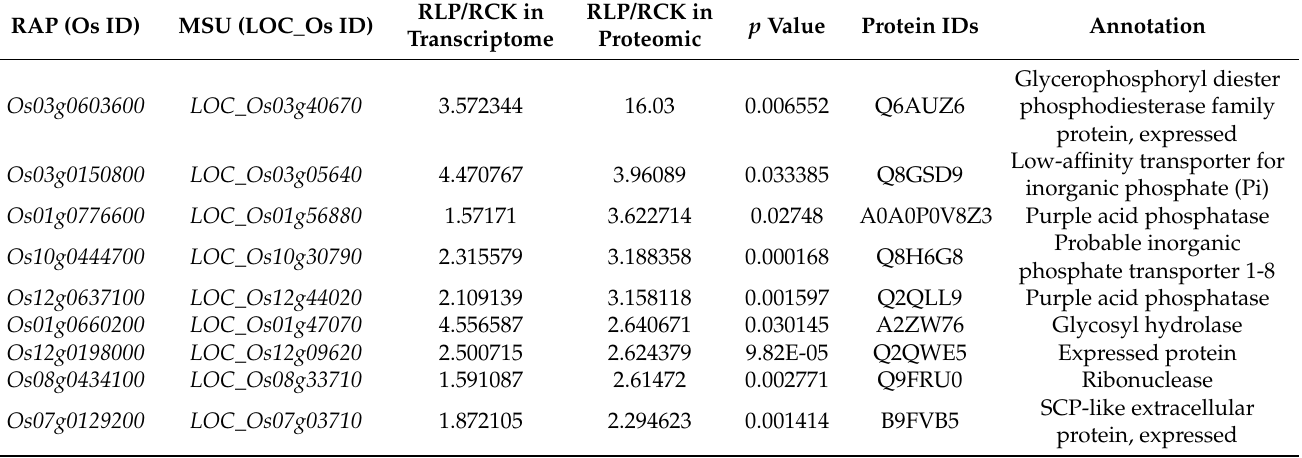
Table 3. Significant differential expression proteins ( p ≤ 0.05) with fold changes both in transcriptome and proteomics level larger than